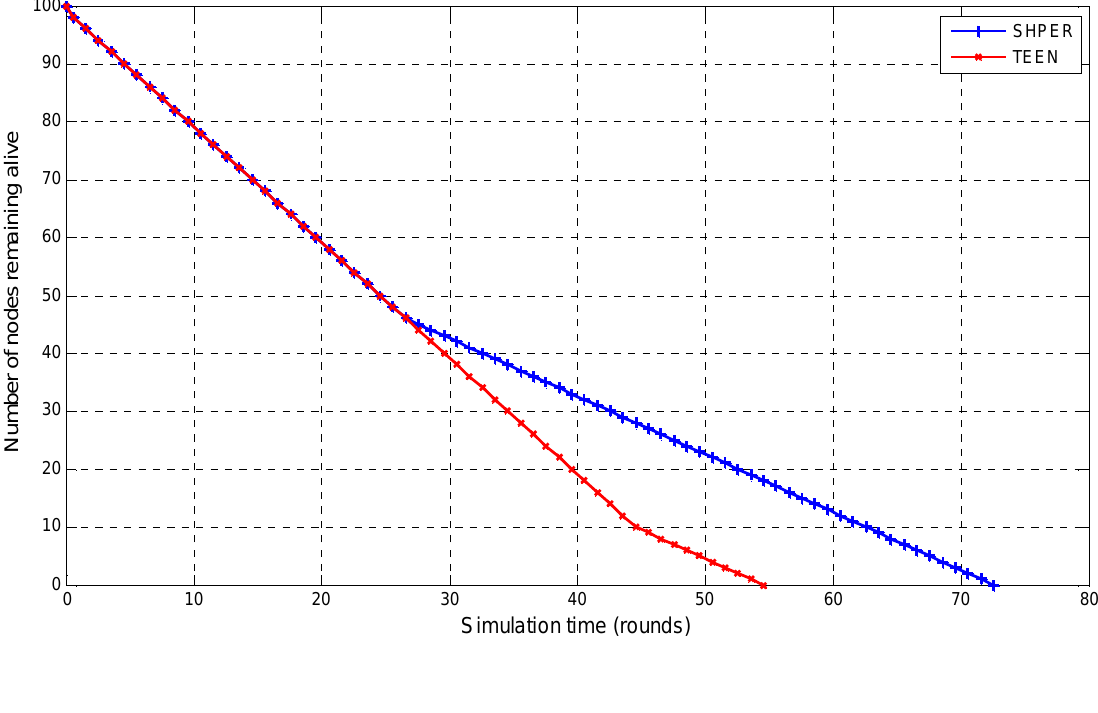
Figure 6. Comparative depiction of the nodes remaining alive over the simulation time steps in SHPER and TEEN [ Er (0) = 0.5 J, D = 300 i